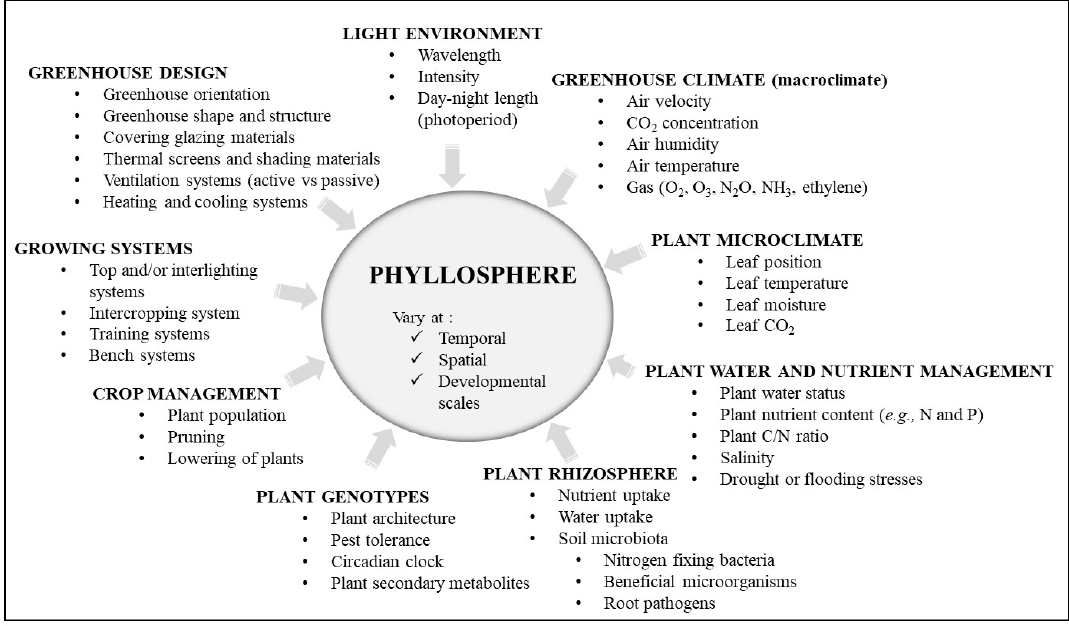
Figure 1. Most important growth parameters affecting the phyllosphere of greenhouse crops. ( Illustration: M. Dorais ) .